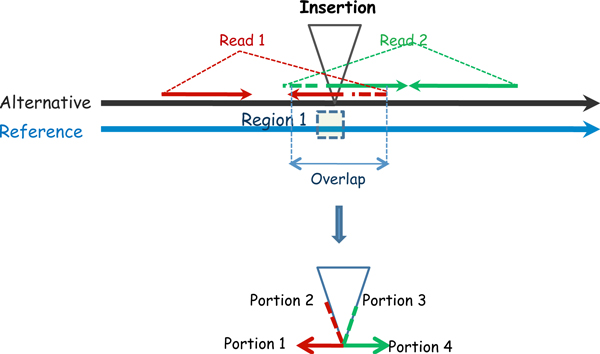
Type III pattern in finding insertion. Tail segments (portions 1 and 4) are mapped next to each other on the reference. The sequences of head segments (portions 2 and 3) belong to the inserted sequence.